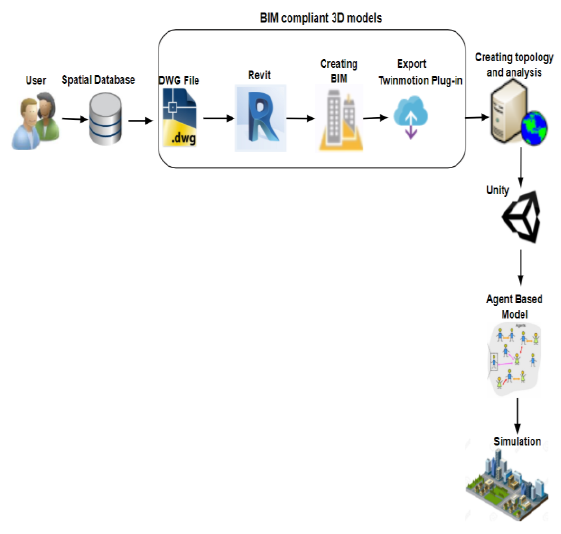
Figure 1. The designed frame-work